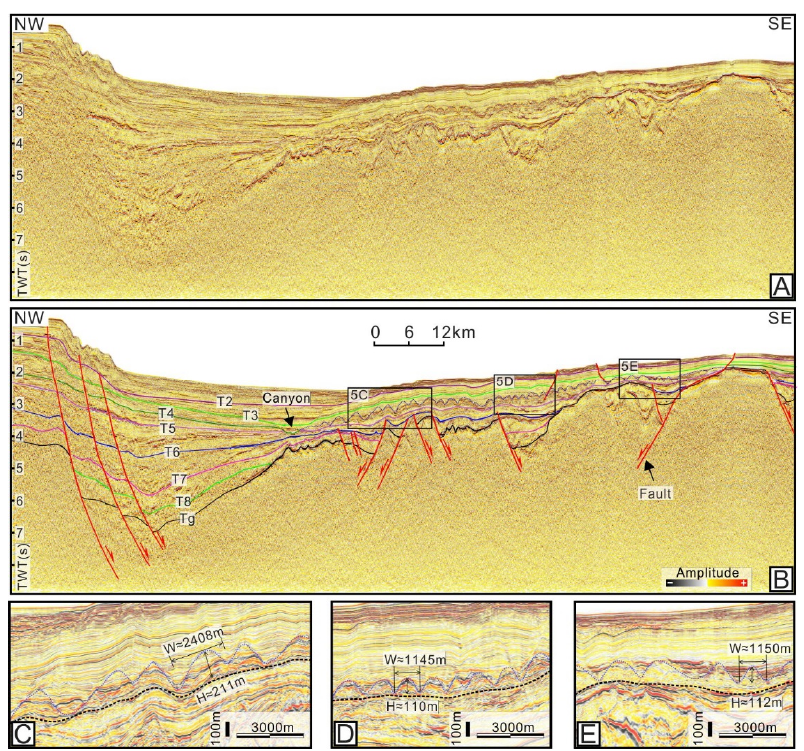
Figure 5. ( A , B ) Uninterpreted and interpreted seismic section traversing the Baodao Sag, showing the stratigraphic and structural characteristics (for location, see Figure 1). ( C – E ) Seismic profiles and their interpretations showing the mounded topography at the top of Meishan Fm (for locations, see Figure 5A). W = width; H = height; TWT = two-way traveltime. Table 1. Reference value of paleo heat flow and water depth during different periods (referenced from [32,53]). HF = Heat flow; PWD = Paleowater depth. HF1, HF2, and PWD1 apply to the northern slope; HF3, HF4, and PWD2 apply to the central depression; HF5, HF6, and PWD3 apply to the southern